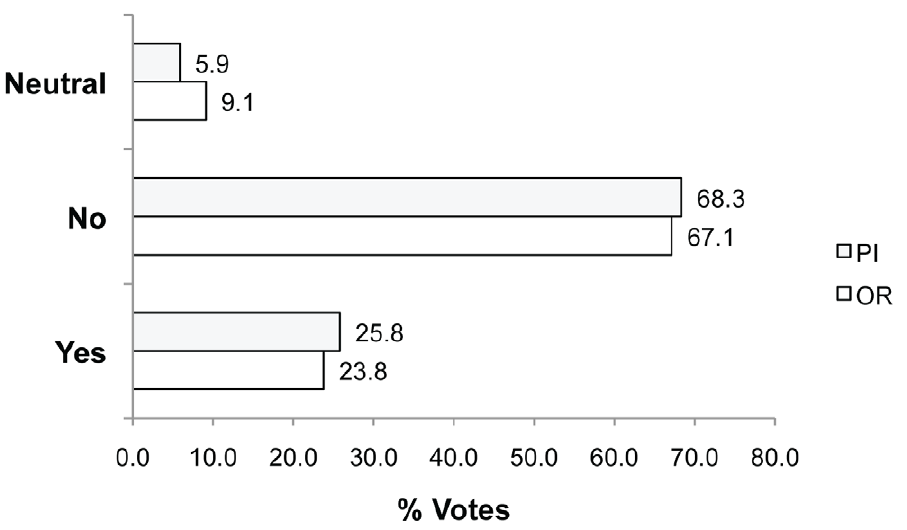
Figure 5. Percent of Yes, No and Neutral votes in response to Q3. Question 3: If the experimental species in question 2 was beagles instead of trout would you change your response?